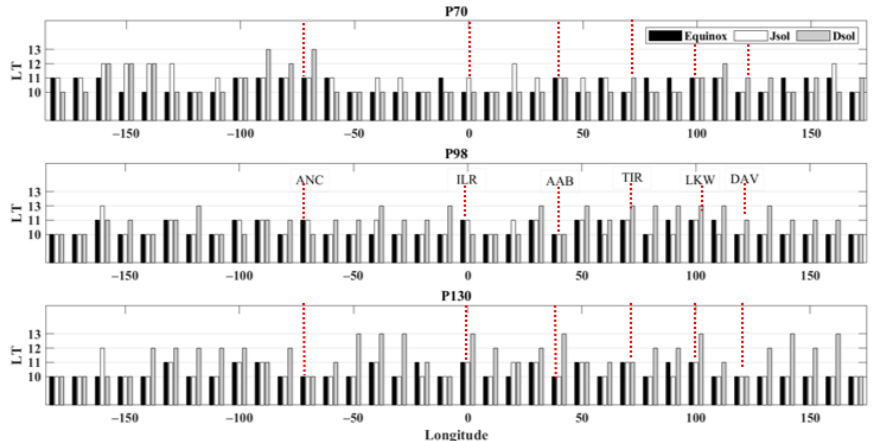
Figure 6. Bar plots for local time vs. longitude for satellite measurements during low (𝑃 = 70), moderate (𝑃 = 98), and high (𝑃 = 130) solar activity levels. The black, white, and grey plots represent the equinox, June solstice and December solstice, respectively. The red lines represent the locations of the ground stations.